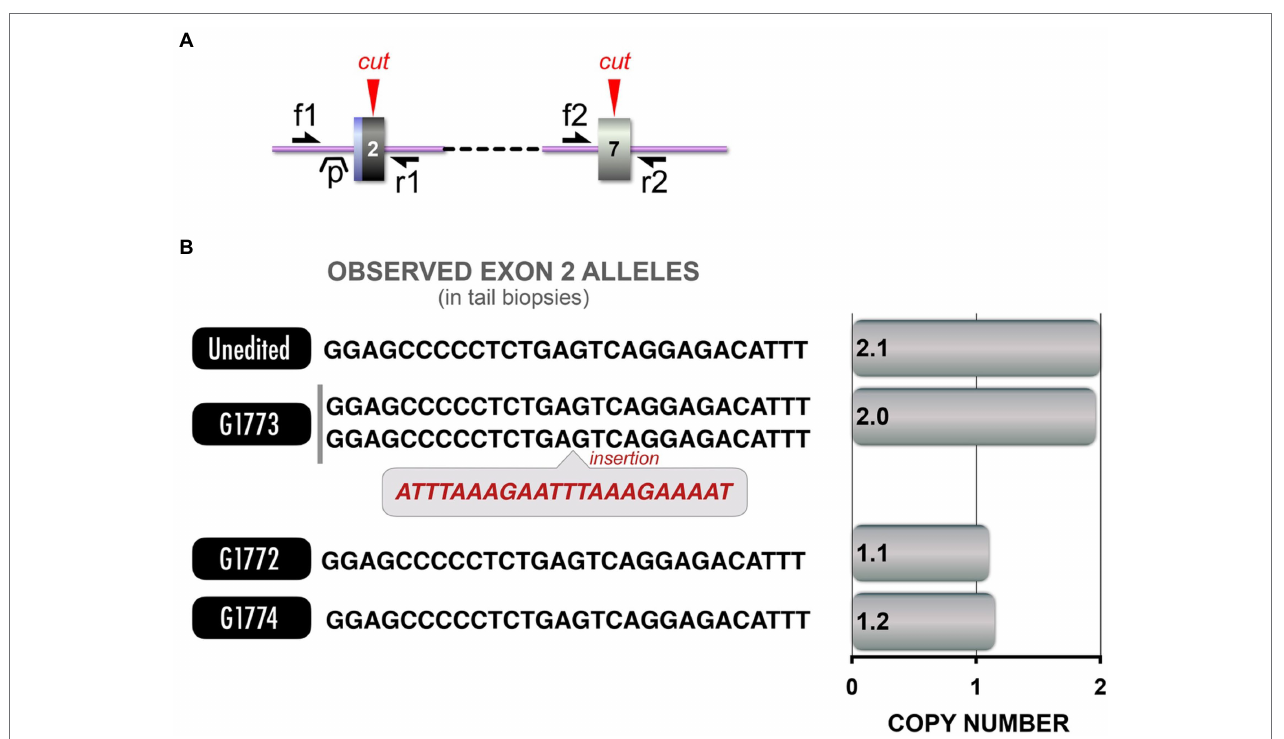
FIGURE 6 | TP53 LOF model and CNV analysis. (A) Schematic depicts Cas9 target sites in exon 2 and exon 7 of TP53 . Red arrowheads: Cas9 cut sites, single- headed black arrows (f1, f2, r1, r2): primer annealing sites for competitive and dPCR (distinct primer sets, see Supplementary Table 2 for primer sequences), “p” indicates dPCR probe annealing site. (B) Left: Allele sequences from each pig are provided, along with the CNV analysis corresponding to those sequences. Right: CNV analysis revealed that while some pigs carried the excision, others carried alleles that could not be